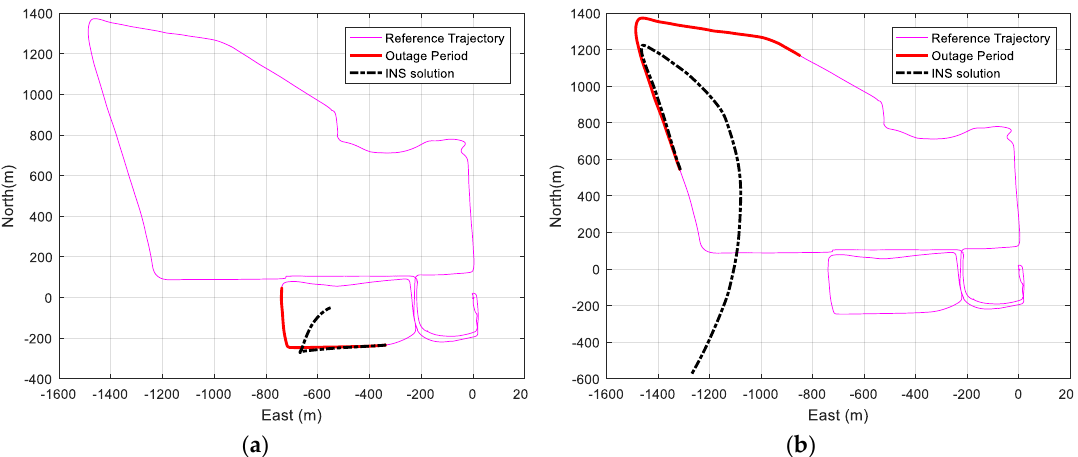
Figure 11. ( a ) Trajectory IMU standalone navigation solution for 60 s GNSS signal outage for a sample outage region. ( b ) Trajectory IMU standalone navigation solution for 120 s GNSS signal outage for another sample outage region.